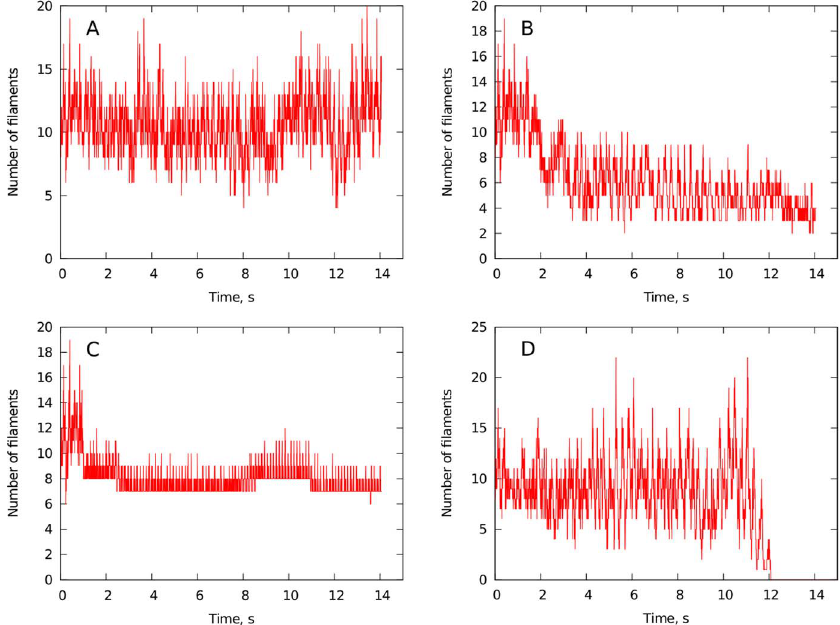
Figure 8. Change of the number of filaments in course of time under different ischemia factors obtained from numerical simulations. A: normal conditions, B: hyperkalemia, C: hypoxia, D: example of spontaneous fibrillation stop.